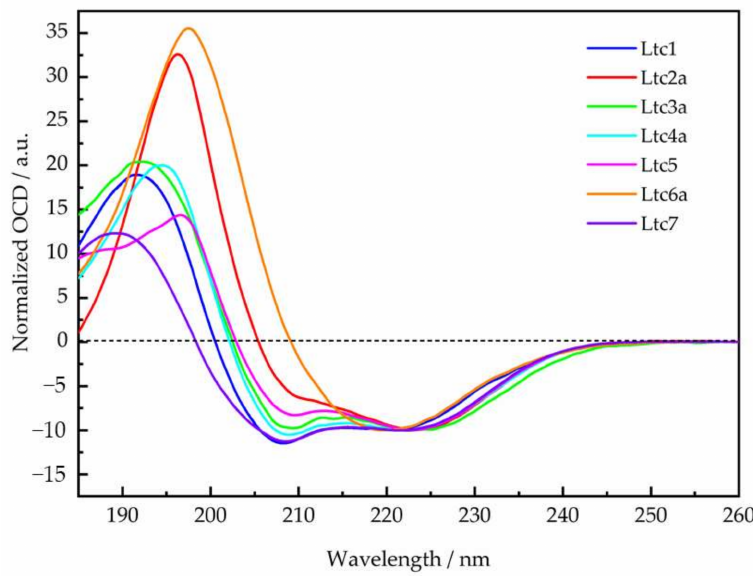
Figure 6. Oriented CD spectra of latarcins in oriented membrane composed of DMPC/DMPG (7/3) at a P/L = 1/100 measured at 30 ◦